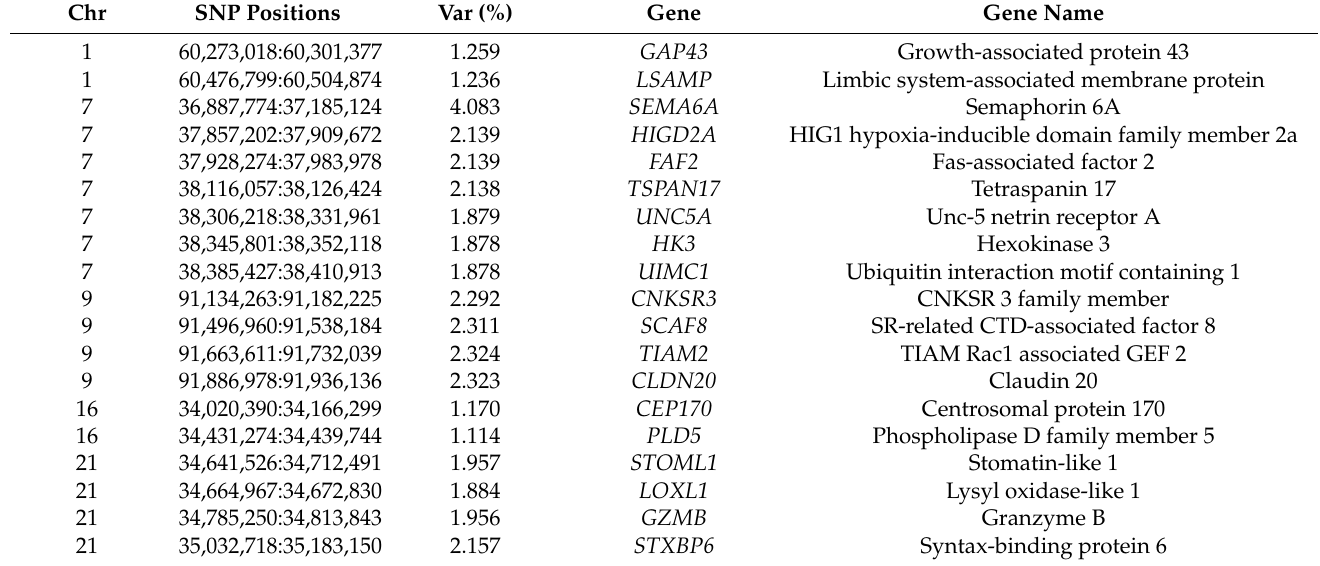
Table 4. Identification and description of genes located in windows associated with visual scores for muscularity (MUSC) that explained more than 1% of the additive genetic